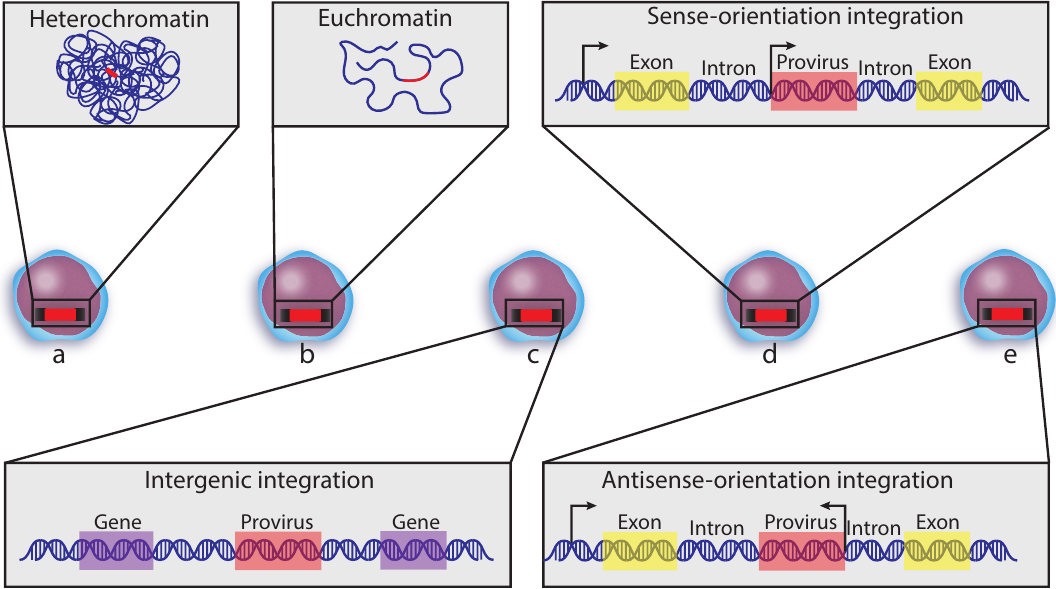
Figure 4. Transcriptional orientation and chromatin states of proviruses. HIV proviruses (red bars) can be found throughout the genome, in both inactive regions of the host genome like heterochromatin ( a ) or actively expressed regions such as euchromatic regions ( b ). They can also be detected in intergenic regions ( c ) but are primarily found as integrations within introns of actively expressed genes ( d , e ) and can integrate in either the sense- or antisense-orientation regardless of their genomic location ( d , e ). Arrows indicate TSS and direction of